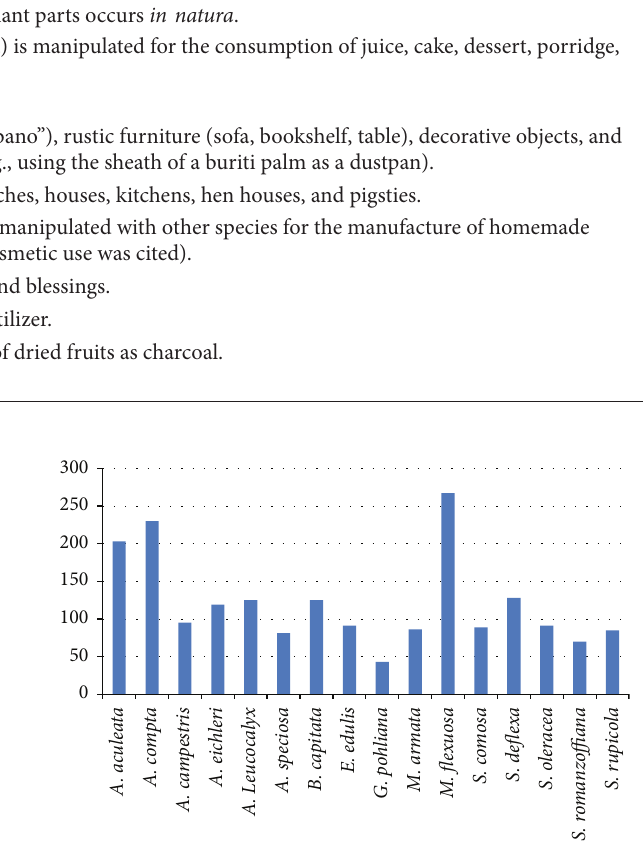
Figure 3: Number of citations of the use of palm species in the Engenho II community, Cavalcante, GO, central western Brazil. ( Acrocomia aculeate , Attalea compta, Allagoptera campestris, Attalea eichleri, Allagoptera leucocalyx, Attalea speciosa, Butia capitata, Euterpe edulis, Geonoma pohliana, Mauritiella armata, Mauritia flexuosa, Syagrus comosa, Syagrus deflexa, Syagrus oleracea, Syagrus romanzoffiana, and Syagrus rupicola )